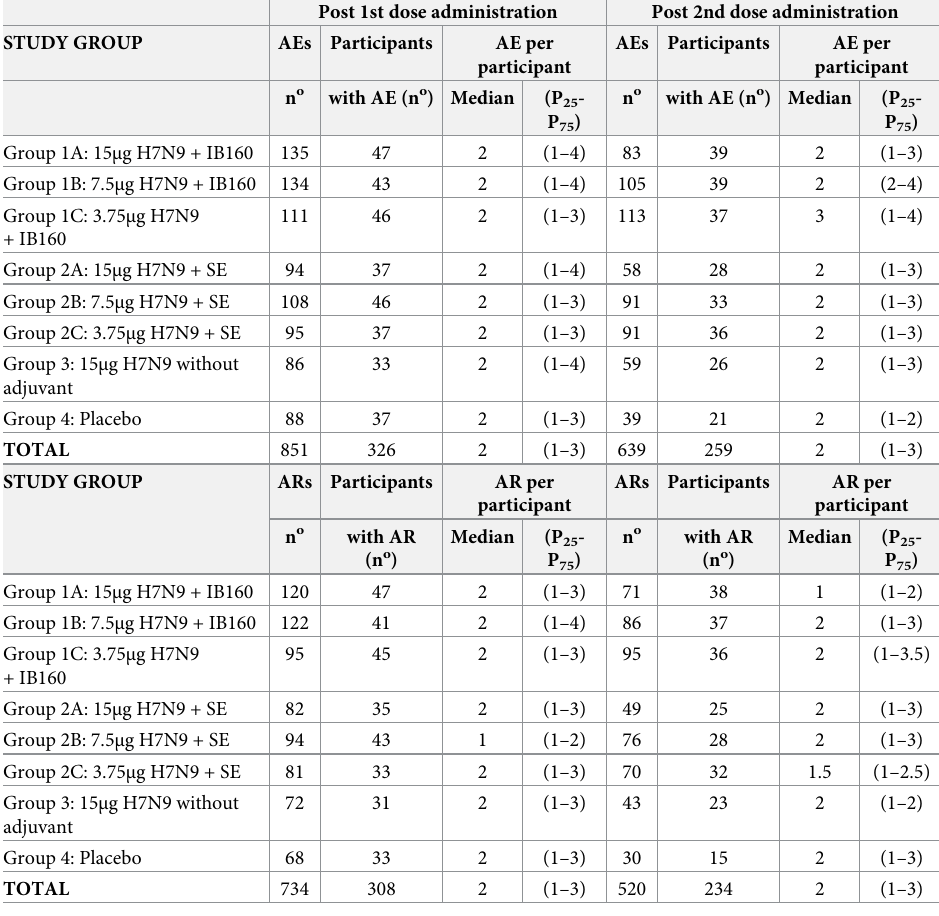
Table 6. Demographic characteristics, prior seasonal influenza vaccine, and study site, by study